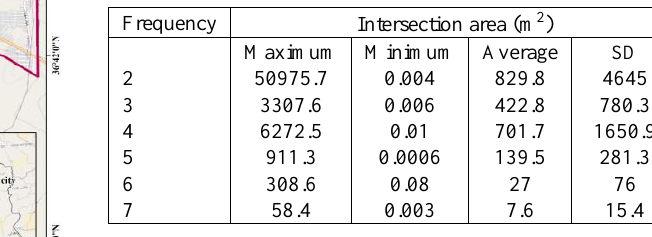
Table 1. Evaluation of the area index in the intersection areas proposed by citizens.